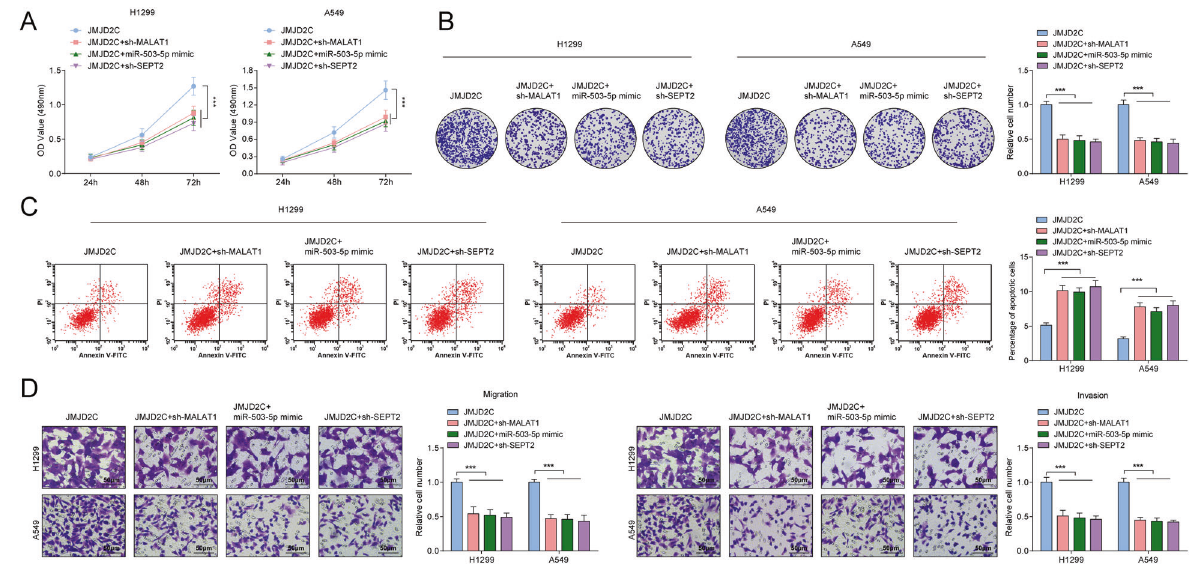
Fig. 5 The promoting effects of elevated JMJD2C on NSCLC are reversed by silencing MALAT1 or SEPT2, or restoring miR-503-5p. A MTT measured the growth curve of A549 and H1299 cells. B Colony formation assay measured colony formation ability of A549 and H1299 cells. C Flow cytometry measured A549 and H1299 cell apoptosis. D Transwell measured cell migration and invasion ability; Data statistics was by t -test, ANOVA, Pearson ’ s correlation analysis.